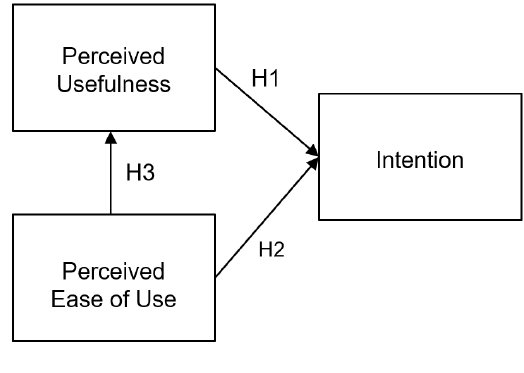
Figure 2. Research Model Measurement Model